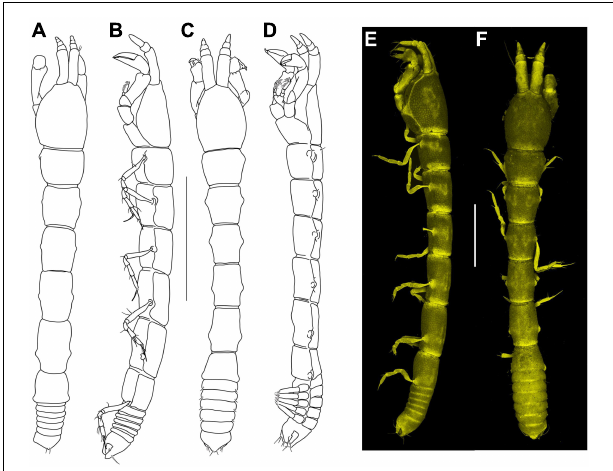
FIGURE 14 | Agathotanais paleroi n. sp., neuter, holotype ( A,B : ZMH K-61175), juvenile male, paratype ( C,D : NHM 58023), neuter, paratype ( E,F : ZMH K-61178). (A) Dorsal view; (B) lateral view; (C) dorsal view; (D) lateral view; (E) lateral view (confocal picture); (F) dorsal view (confocal picture). Scale bars: (A–D) = 1 mm, (E,F) = 500 µ m.